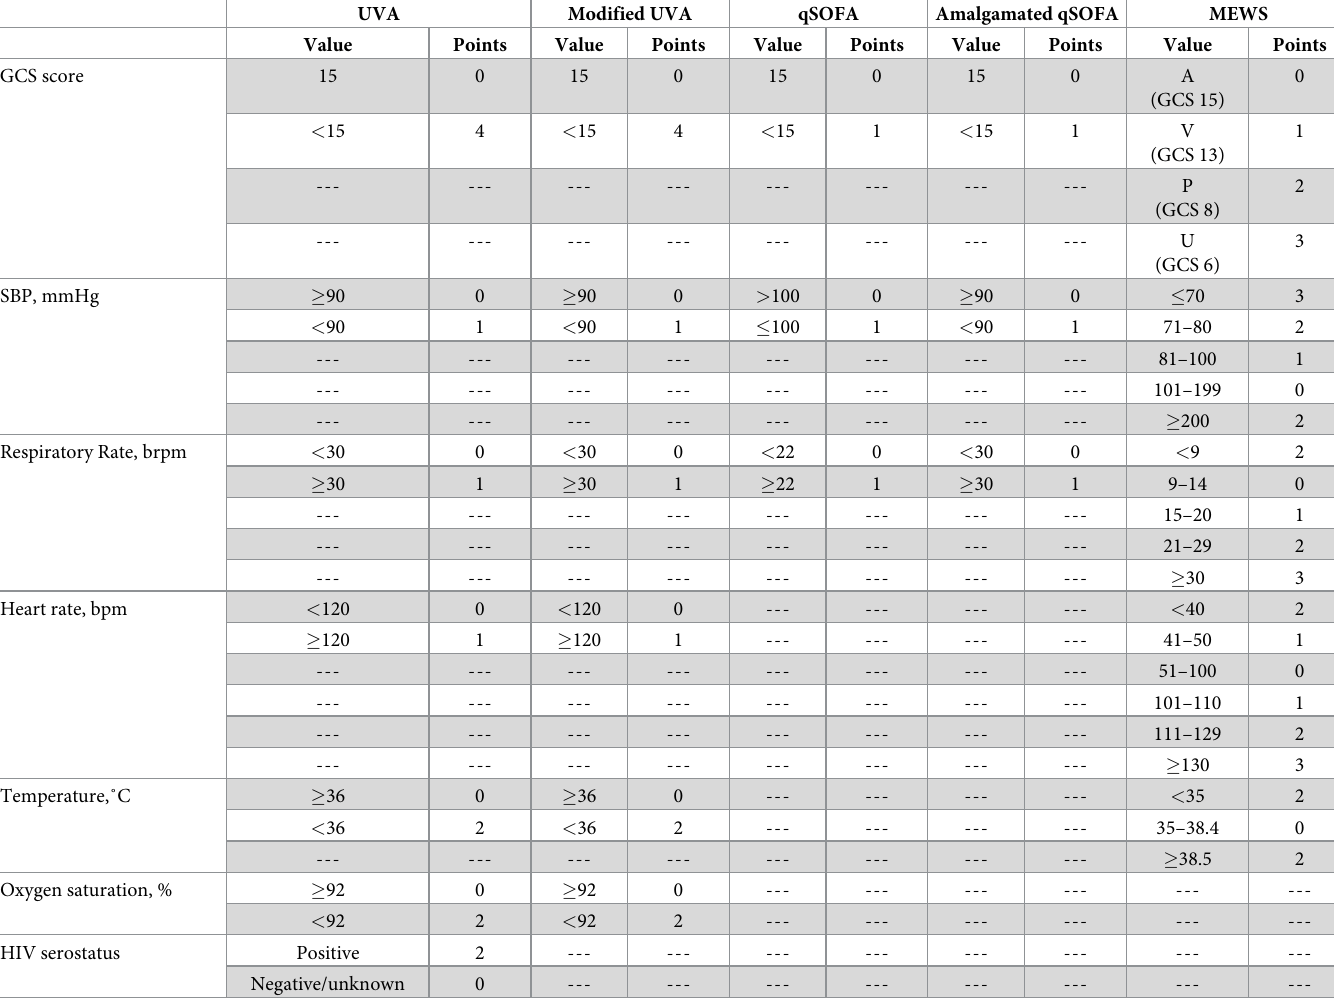
Table 1. A comparison of clinical mortality risk score components and their associated point